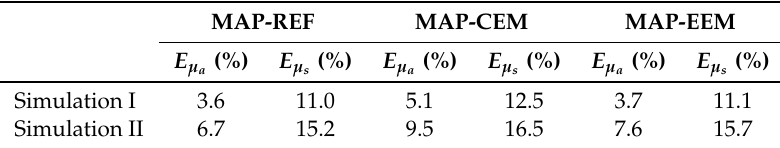
Table 3. Relative errors of the MAP-REF, MAP-CEM and MAP-EEM reconstructions compared to the true values. E µ is the relative error of the absorption coefficient and E µ a scattering